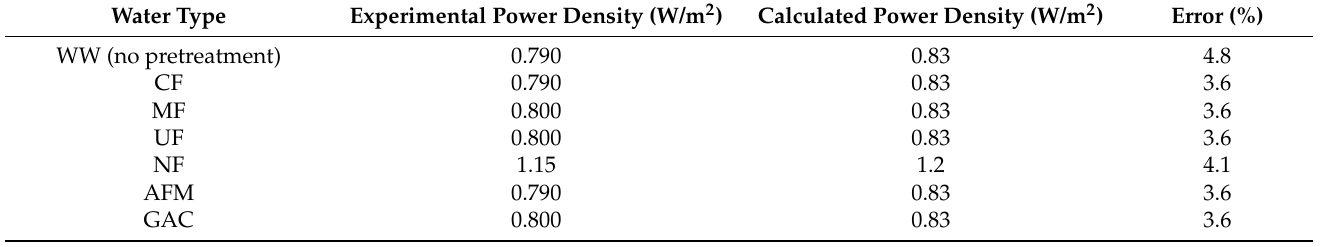
Table 7. Power density in RED using raw feed water (WW) and pretreated water.